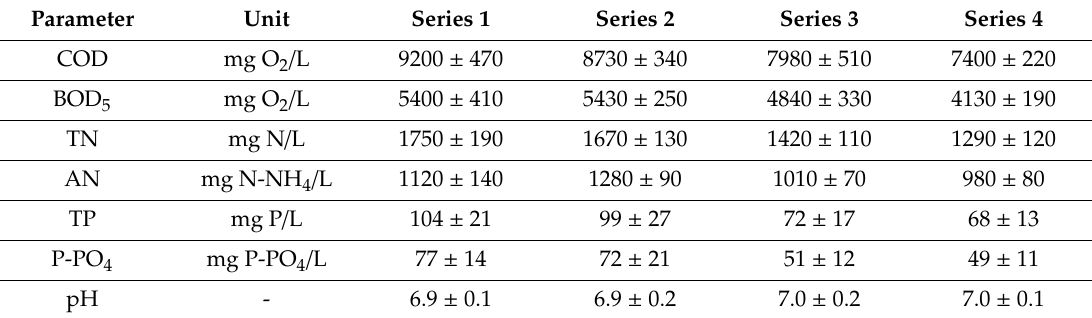
Table 2. Liquid anaerobic digestate